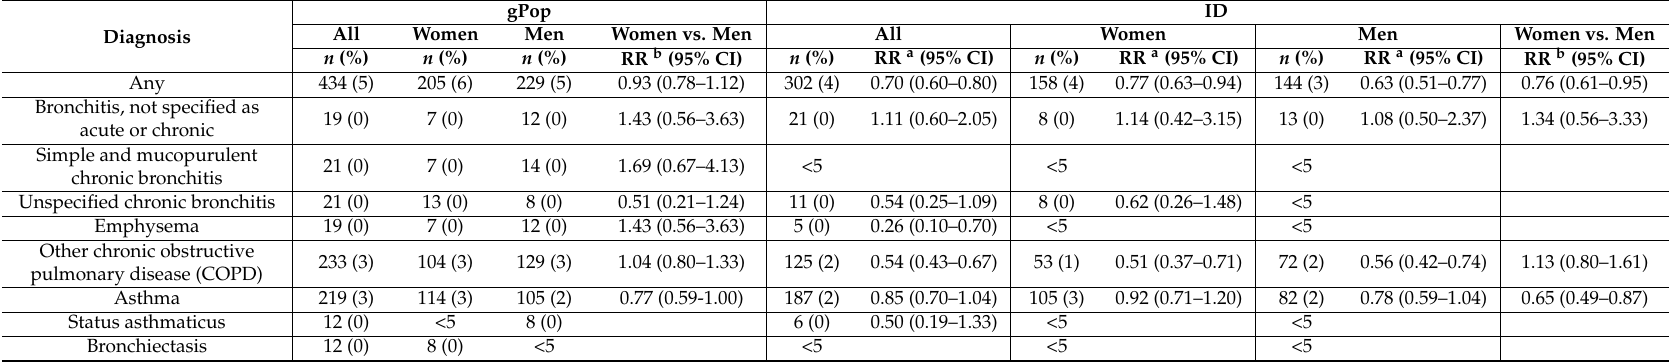
Table 3. The number of people with at least one diagnosis (primary or secondary) of different types of chronic respiratory diseases in a cohort of people with intellectual disabilities (ID, n = 7936, 3609 women and 4327 men) and a same-sized referent sample from the general population (gPop), matched by sex and year of